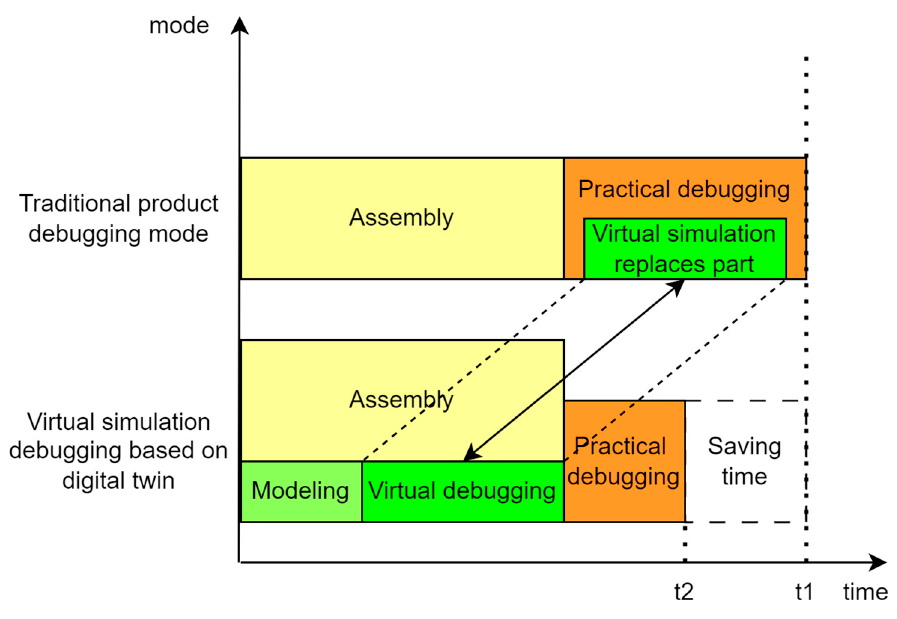
Figure 23. Product debugging mode comparison diagram.